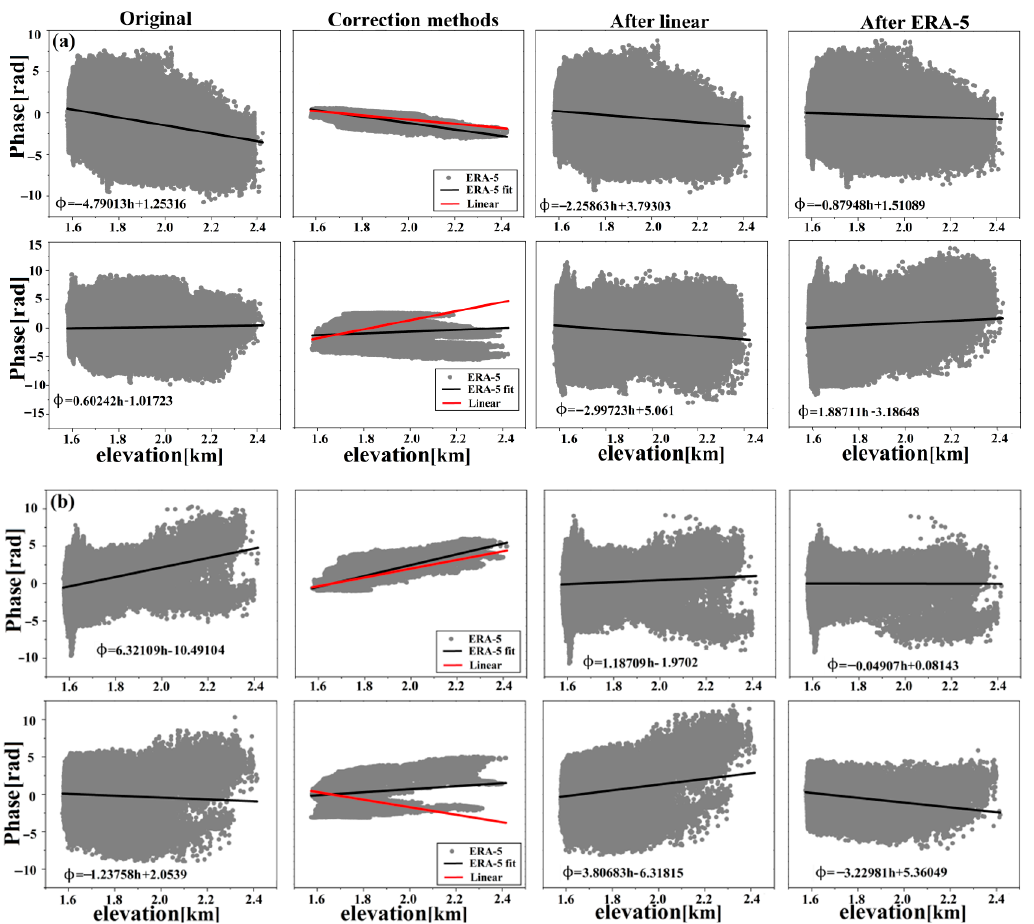
Figure 7. Interferogram phase versus elevation before and after ERA-5 and linear model correction (black line indicates the linear relationship between atmospheric delay and elevation calculated by ERA-5). ( a ) Radarsat-2 phase and elevation relations before and after atmospheric correction (stratified delay dominates in the first row and turbulent mixing delay dominates in the second row). ( b ) Sentinel-1A phase and elevation relationship before and after atmospheric correction (stratified delay dominates in the first row and turbulent mixing delay in the second row).